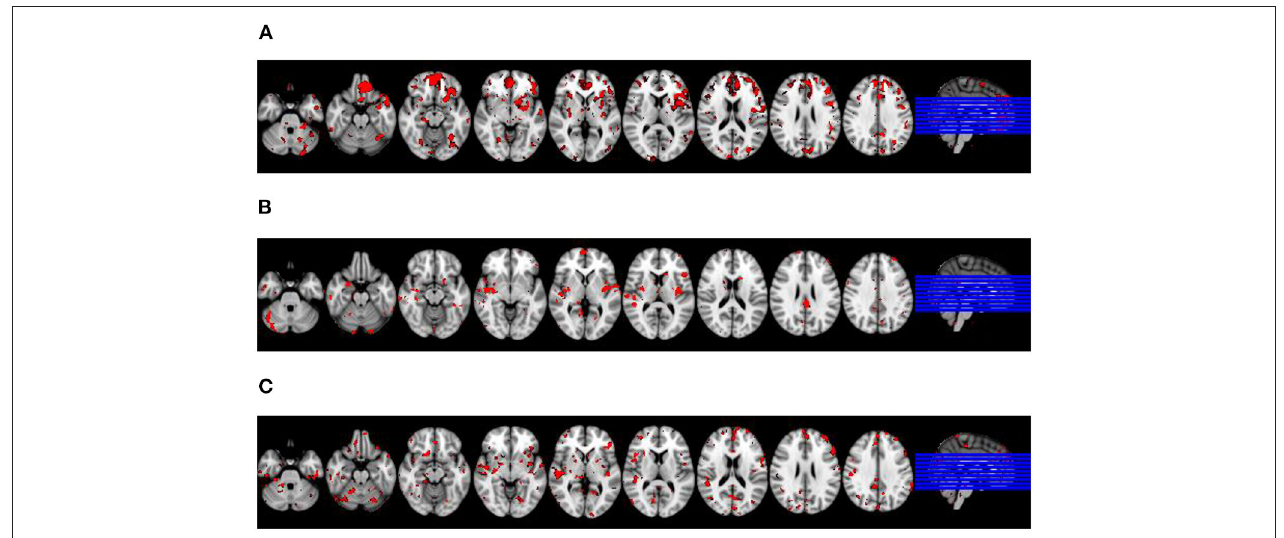
FIGURE 4 | Differences in spatial expression of spatial ICA components between diagnostic groups. Latent variable representing brain regions where spatial expression of the respective rs-fMRI component was significantly associated with diagnosis projected on an MRI scan in MNI standard space. Axial sections go left to right from MNI coordinate z = − 30 to z = 34; sections are 8mm apart. Right of image is right of brain, view from superior. Red colored voxels represent a significant bootstrap ratio of p < 0.05, with an increased expression in (A,C) , and a decreased expression in (B) , respectively, in AD patients compared with controls. (A) Frontal lobe network. (B) Default lobe network. (C) Temporal lobe